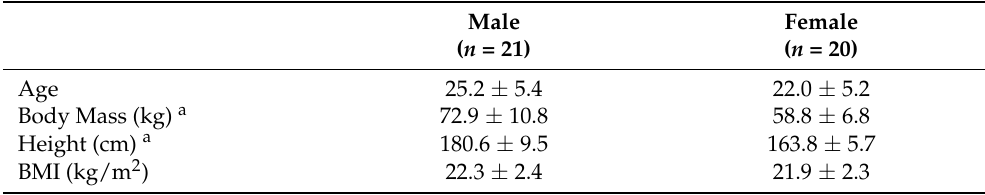
Table 1. Participant characteristics.